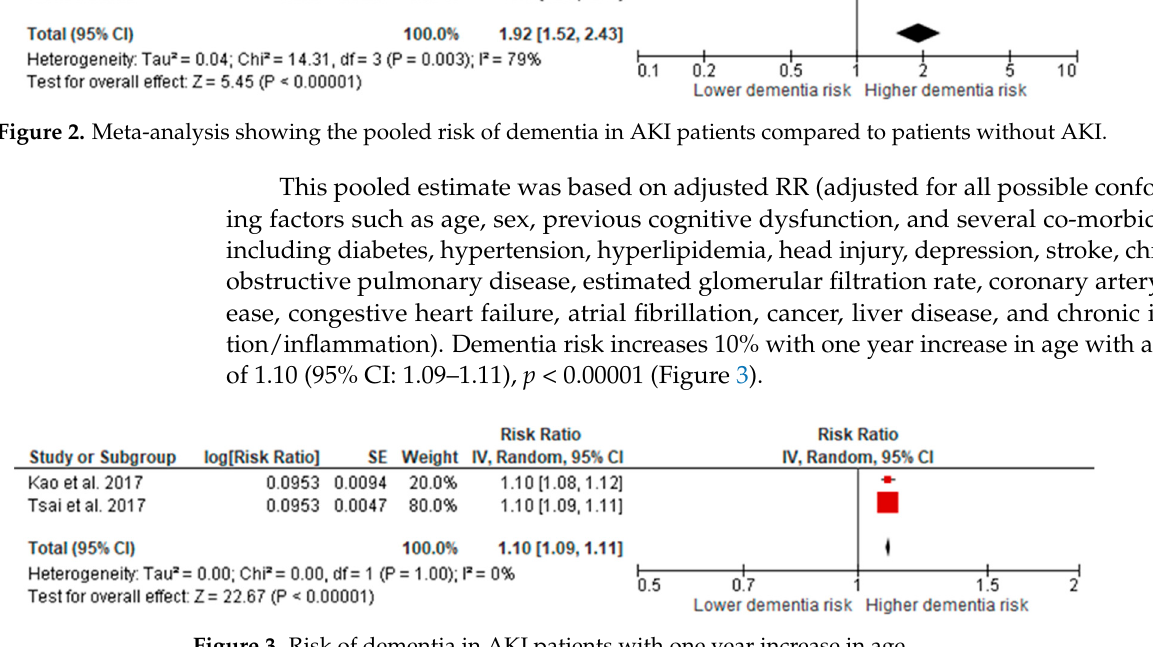
Figure 4. Risk of dementia in AKI patients with stroke . All-cause mortality risk was also significantly higher (Figure 5) in AKI patients with dementia than patients without AKI with a pooled RR of 2.11 (95% CI: 1.20–3.70), p = 0.009. Only one study analyzed and reported a higher dementia risk with a hazard ratio of 2.01 (95% CI: 1.19–3.39), p = 0.01 in AKI patients who survived at least 90 days after recovery from acute dialysis.